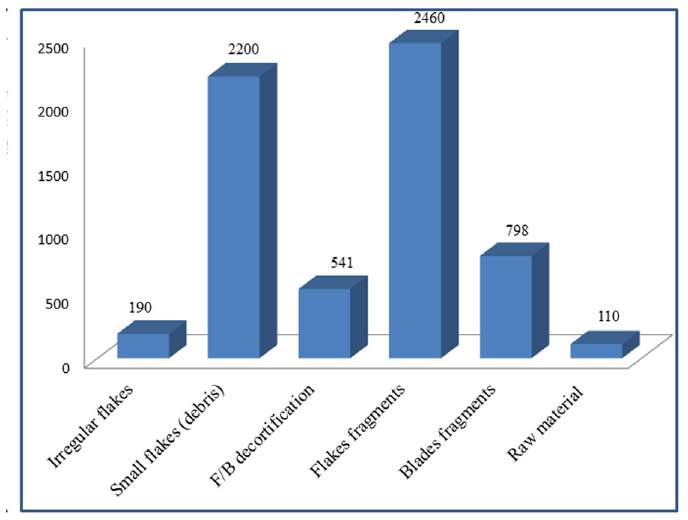
Figure 3. Lipari, Contrada Diana trench XVII. Histogram 1: products of the second stage of